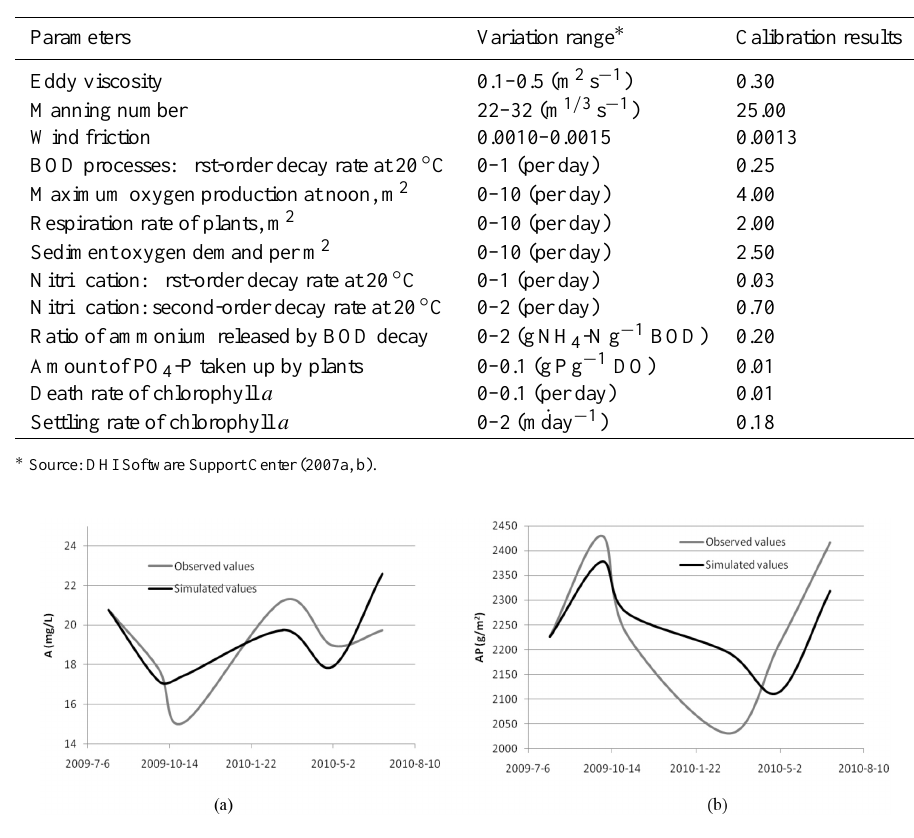
Table 4. Calibrated parameter values.